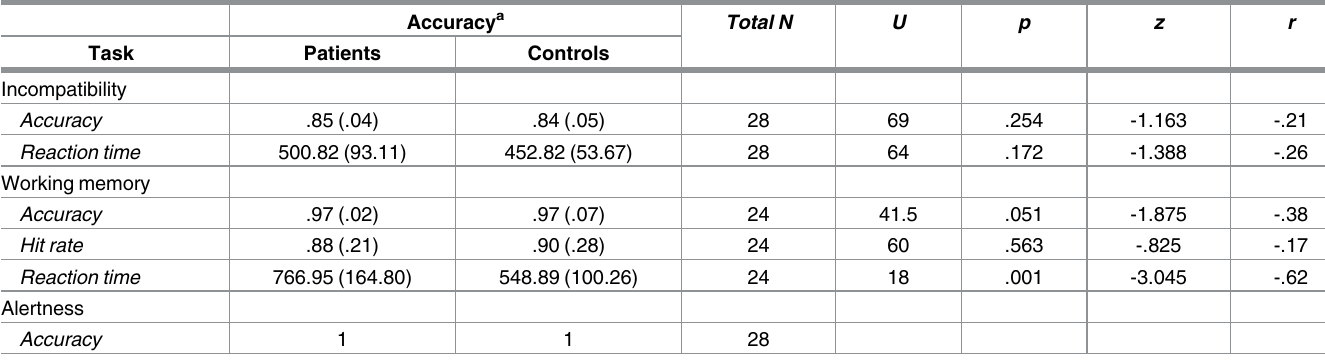
Table 2. Group comparisons of performance in the three cognitive